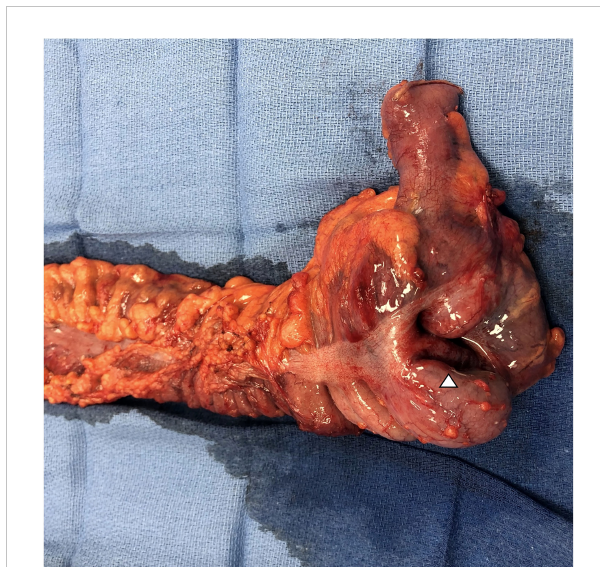
FIGURE 3 Photo of surgical resection specimen with terminal ileum, ileocecal valve, cecum, and ascending colon. The triangle denotes the location of the intussusception that appears to originate at the level of the coalescence of the tinea at the base of the cecum. Final pathology demonstrated advanced colitis and cecal